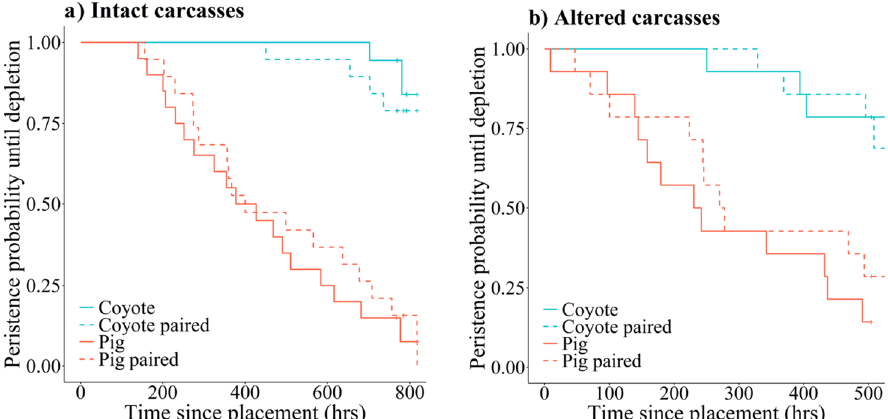
Figure 1. Kaplan-Meir survival function estimate of the probability of the four carcass configurations persisting on the landscape until depletion for ( a ) intact carcass trials and ( b ) altered carcass trials conducted February– June 2021 at the Savannah River Site, Aiken, SC, USA. Censoring is indicated by the plus sign tick marks.